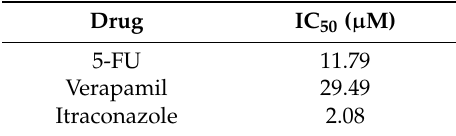
Table 1. Obtained IC 50 values for 5-FU, verapamil and itraconazole on the viability of MCF-7 cells, with the corresponding 95% confidence intervals.